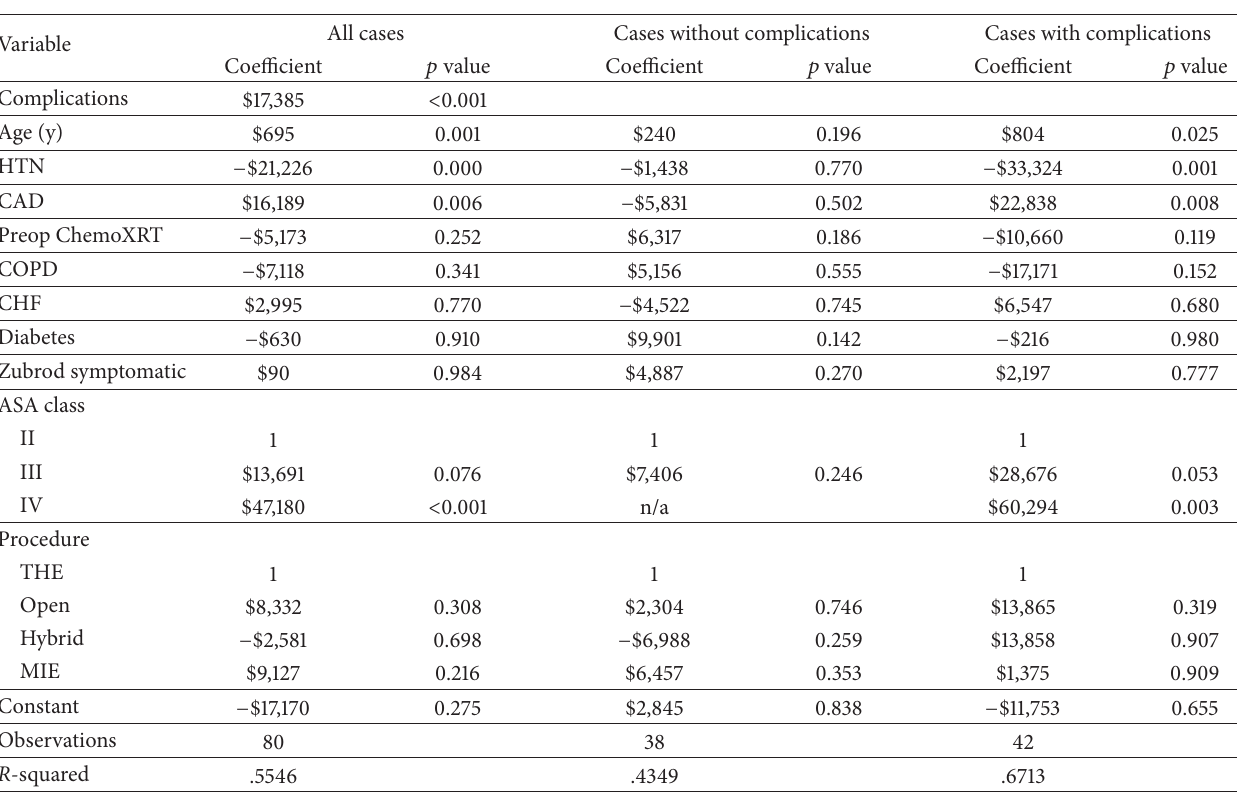
Table 3: Multivariate regression